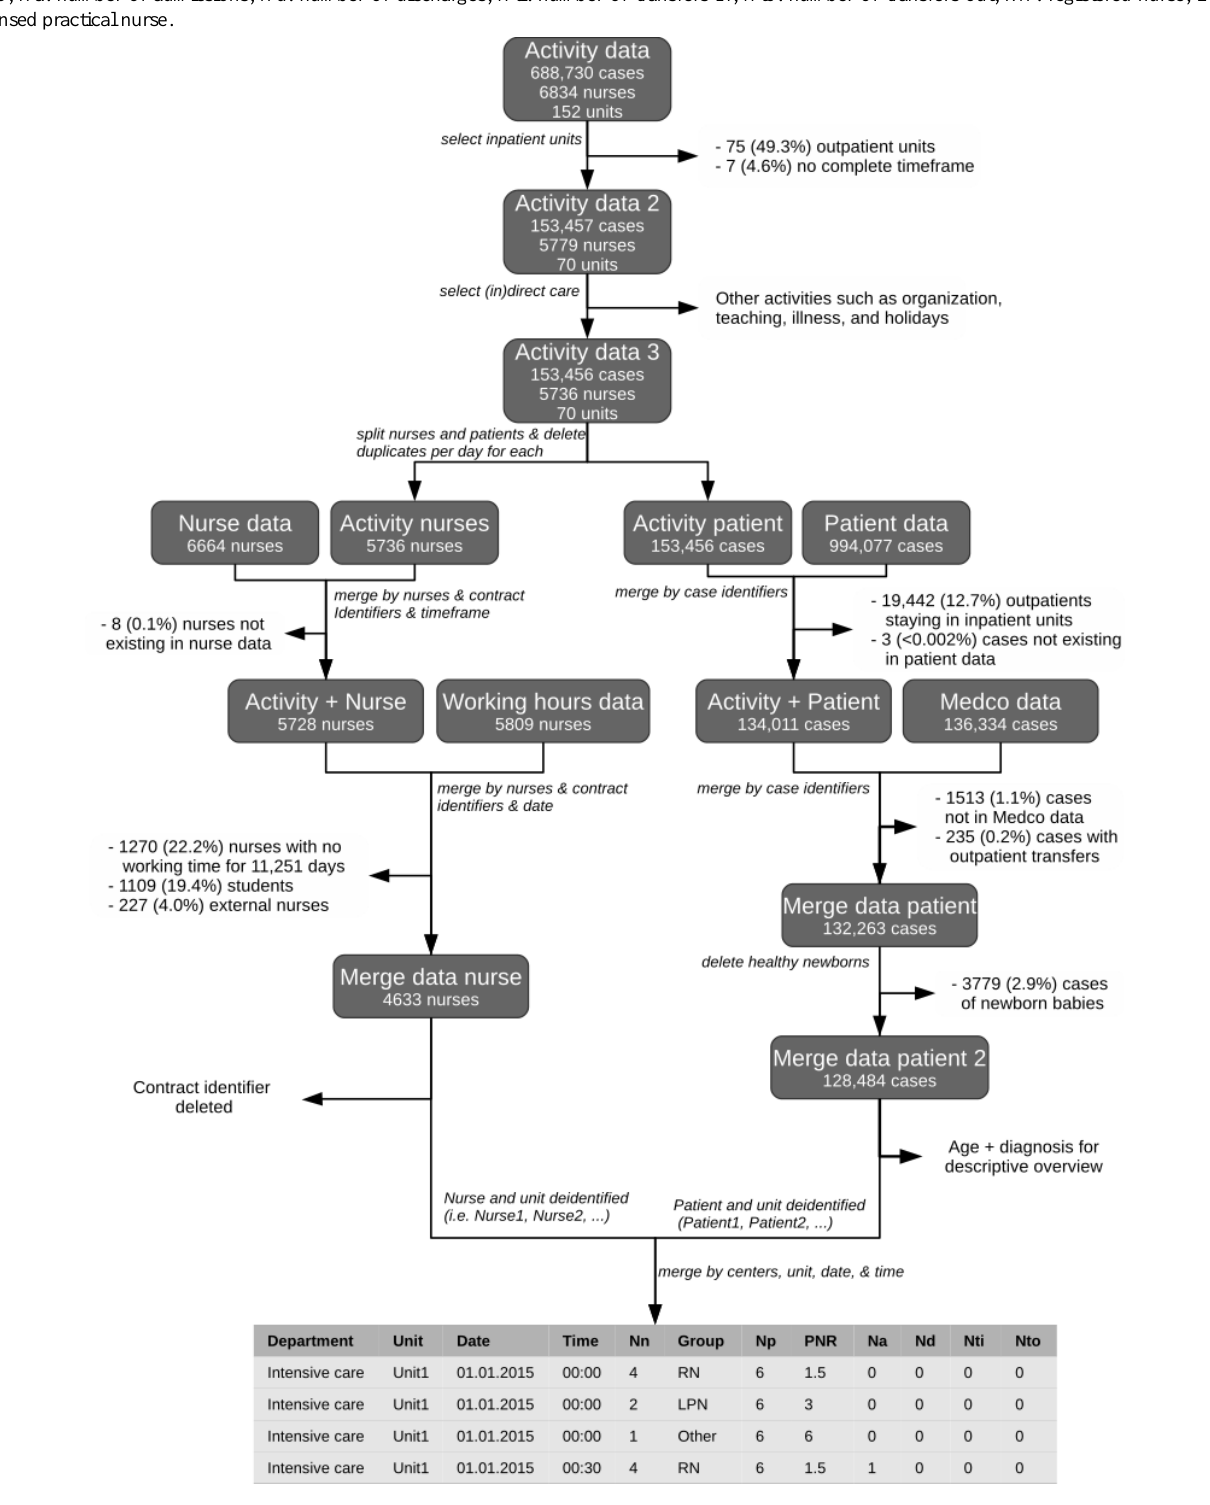
Figure 1. Process to link the two datasets and variables used for the analysis. Nn: number of nurses; Np: number of patients; PNR: patient-to-nurse ratio; Na: number of admissions; Nd: number of discharges; Nti: number of transfers in; Nto: number of transfers out; RN: registered nurse; LPN: licensed practical